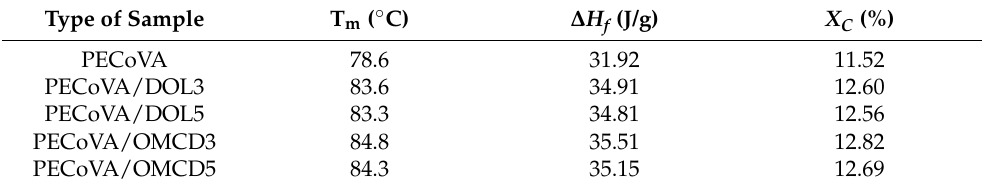
Table 8. Melting temperature of virgin PECoVA, PECoVA/DOL and PECoVA/OMCD composites. Type of Sample T m ( ◦ C) ∆ H f (J/g) X C (%) PECoVA